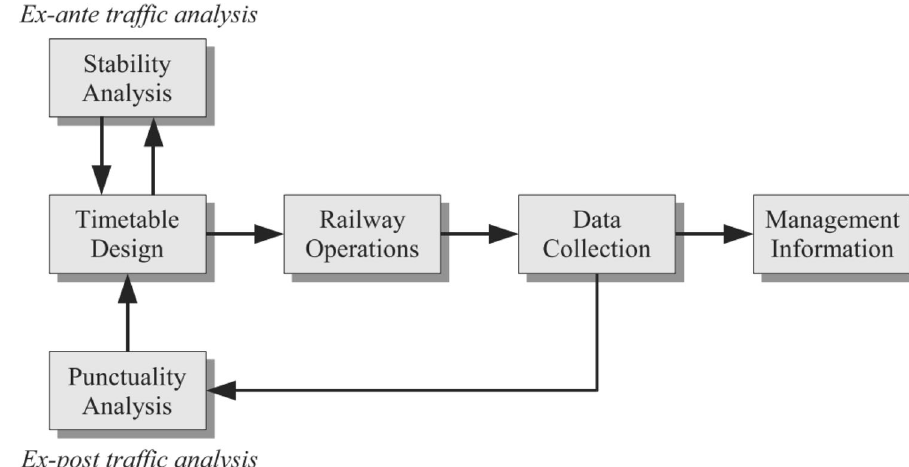
Fig. 12 Feedback cycles in the railway timetabling process